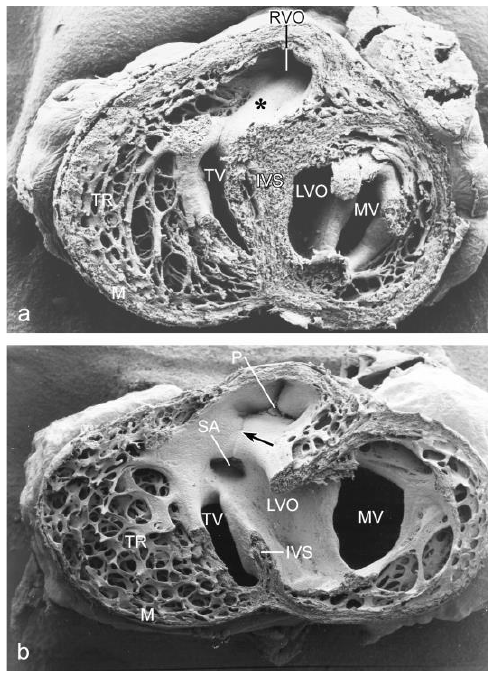
Figure 3. SEM of HH34 postseptation embryos viewed from apex to base. ( a ) Normal heart. The subpulmonary infundibulum (*) is continuous with the interventricular septum (IVS). ( b ) Ligated embryo with a subaortic ventricular septal defect (VSD). The line of the fused OFT cushions is indicated (arrow). Both arterial orifices (SA and P) are situated above the right ventricle (double outlet right ventricle). The aorta is stenotic (SA) and the mitral valve leaflets (MV) are abnormal. The myocardium is severely affected, as seen by a thin IVS and compact layer (M) and spongy trabeculations (TR). IVS: interventricular septum, LVO: left ventricular OFT, M: compact myocardium, MV: mitral valve, P: pulmonary orifice, RVO: right ventricular OFT, SA: stenotic aorta, TR: trabeculations, TV: tricuspid valve.